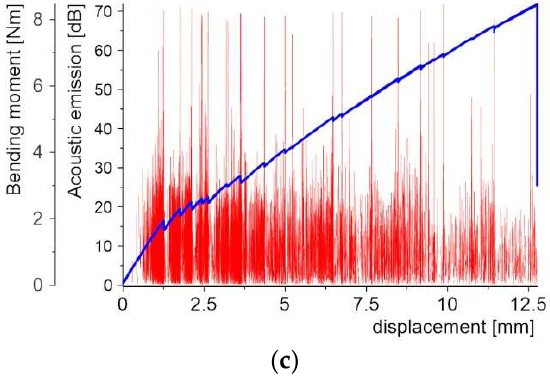
Figure 9. Bending moment and AE vs. displacement diagrams for 3 specimens with the quartz sand PL: ( a ) sample 2_1; ( b ) sample 2_2; and ( c ) sample 2_3.